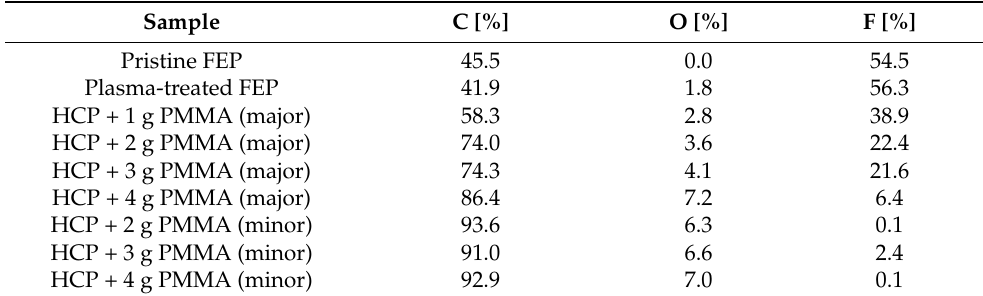
Table 1. The atomic concentrations of fluorine, oxygen, and carbon in at. % were determined using the energy-dispersive X-ray spectroscopy for unmodified pristine fluorinated ethylene propylene (FEP), plasma-treated FEP, and with a honeycomb-like pattern (HCP) major and minor structure